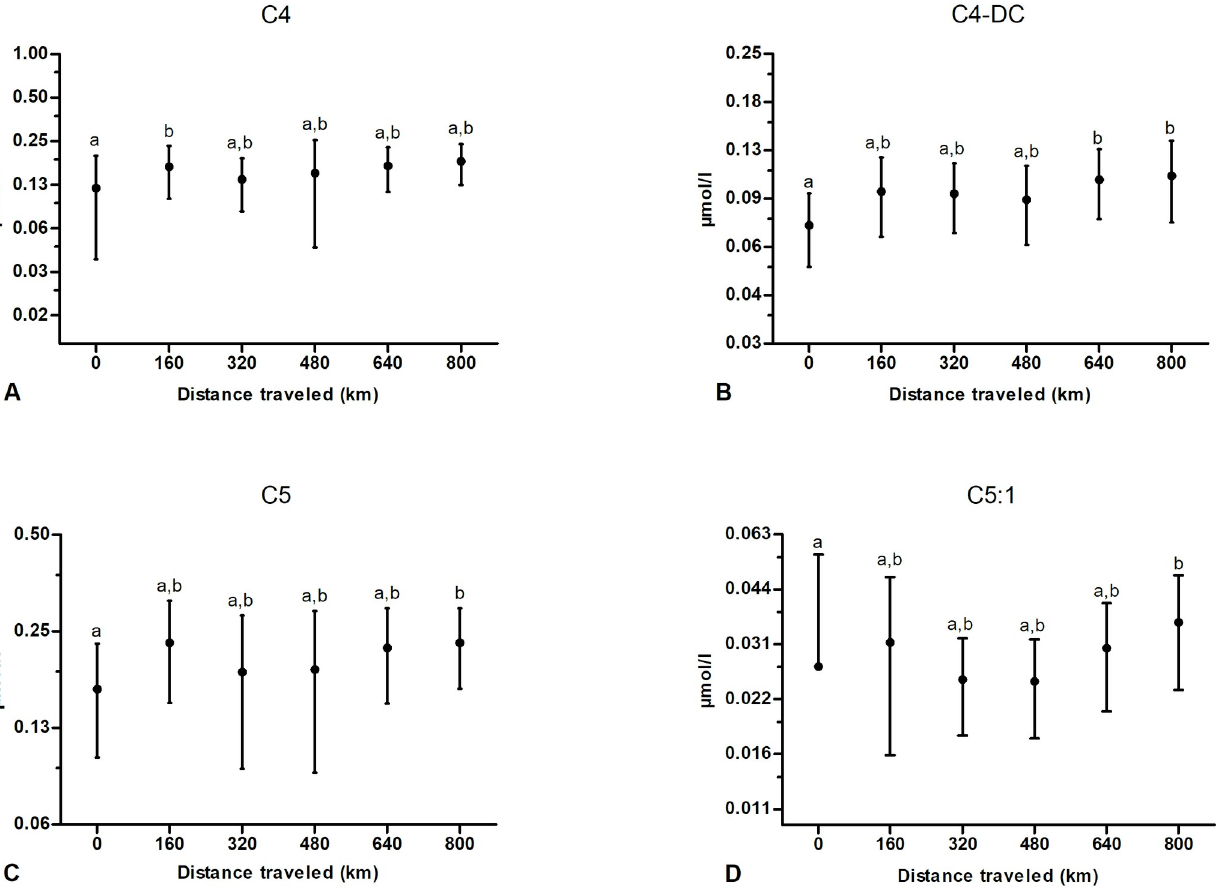
Fig 2. Effect of multiday exercise on some plasma short-chain acylcarnitines (SCACs). Samples were obtained from 9 dogs at 0, 160, 320, 480, 640 and 800 km. Data are displayed as raw data (mean ± SD) on a logarithmic axis. Columns with different superscripts (a, b) are significantly different between them ( P < 0.05) and not significantly different from columns with the same superscript. Missing low error bars correspond to negative values that cannot be displayed on a logarithmic axis.